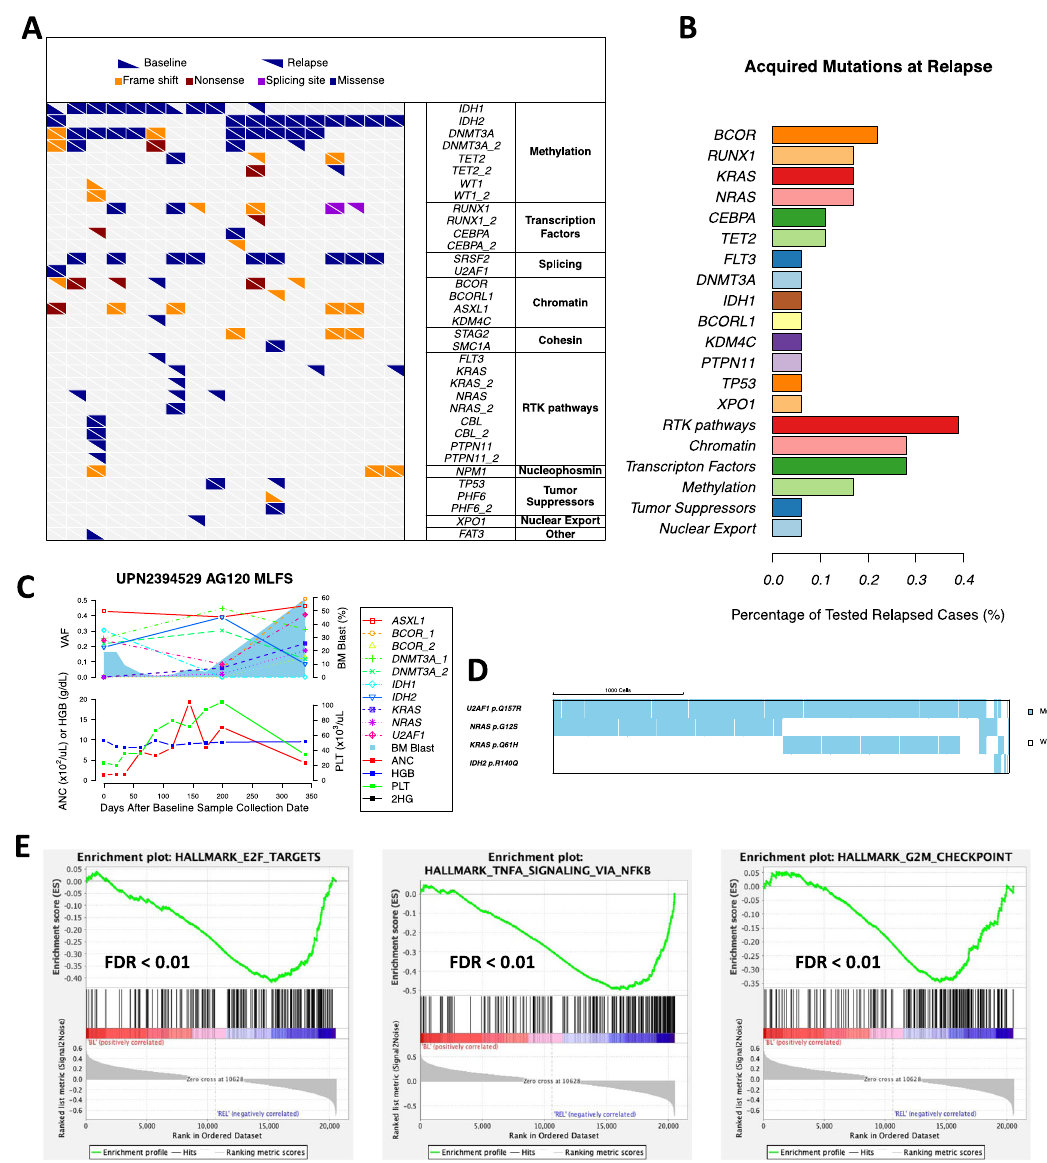
Fig. 5 Selection of resistant mutations accompanies relapse after IDHi. A Longitudinal mutation landscape plot showing mutation acquisitions in 16 out of the 18 tested relapsed cases. Each column represents an individual case with differentially shaped triangles representing mutation status in either baseline or relapse. B Bar plot showing percentage of tested relapsed cases with acquired mutations in various genes and pathways. C The longitudinal trajectory of mutation VAFs, bone marrow (BM) blast counts, absolute neutrophil count (ANC), hemoglobin (HGB) counts, and platelet (PLT) counts in UPN2394529 ( C ). Line plots show mutation VAFs and ANC/HGB/PLT counts. Blue shades represent BM blast counts. D Single-cell landscape of selected mutations in UPN2394529. Each column represents one individual cell. A total of 1000 cells scale bar is shown on the top left. E GSEA comparing gene expression data from RNA sequencing between baseline and relapse samples showing signi fi cant enrichment of E2F targets, TNF alpha signaling via NF- kappa B, and G2M checkpoint genes, in relapse samples. Source data are provided as Source data fi